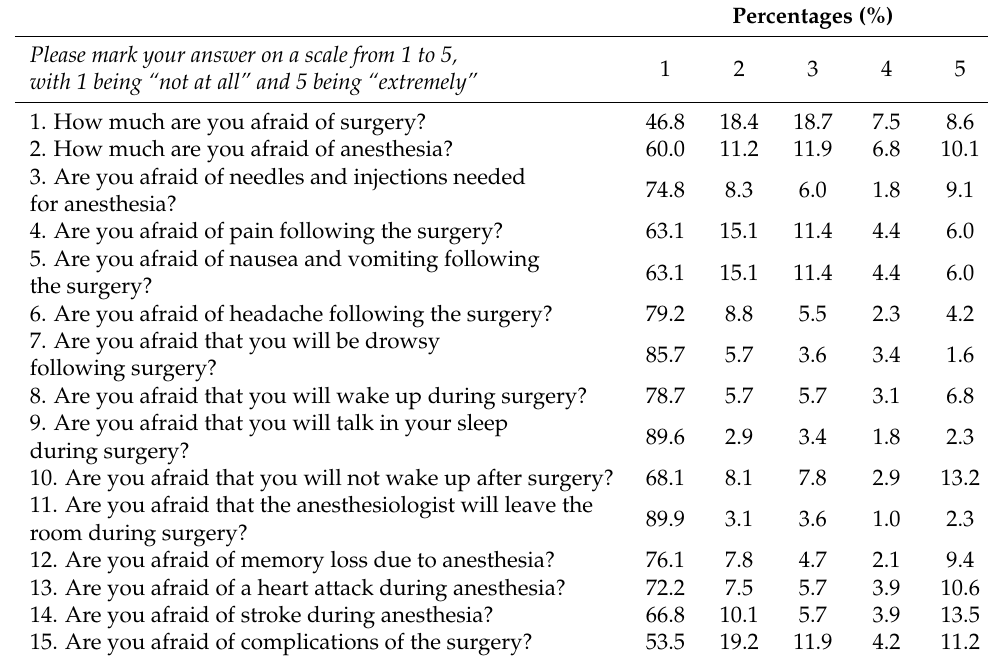
Table 2. Questions for the assessment of specific